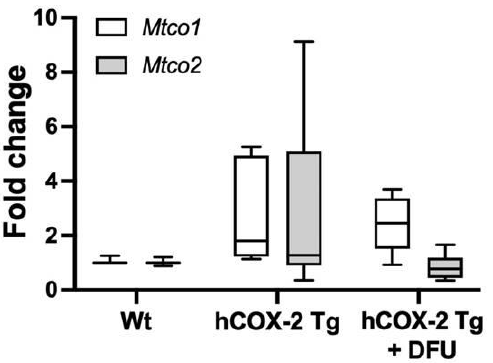
Figure 8. Gene expression of complex IV subunits is not modified in hCOX-2 Tg mice. Quantities of Mtco1 and Mtco2 mRNAs (the R 0 values) were determined in hearts from Wt ( n = 25), hCOX-2 Tg ( n = 20), and hCOX-2 Tg mice treated with the COX-2 inhibitor DFU ( hCOX-2 Tg +DFU, n = 13) using LinRegPCR data analysis. The amount of mRNA was then divided by the R 0 value of Gapdh as normalization. Data are expressed as fold change relative to Wt mice.